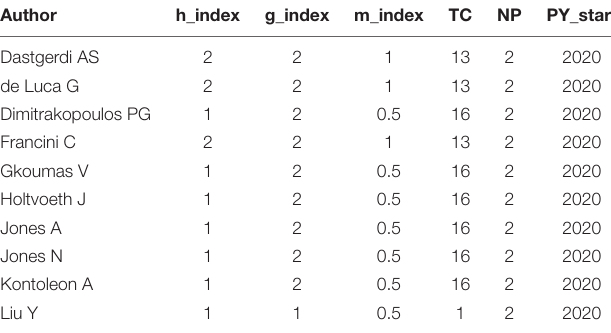
TABLE 4 | Top 10 authors with source impact.